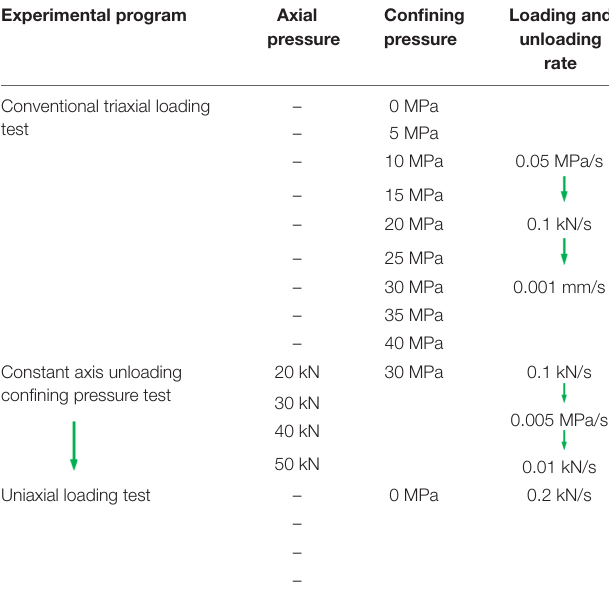
TABLE 1 | Conditions of triaxial loading/unloading tests and uniaxial loading tests under different confining